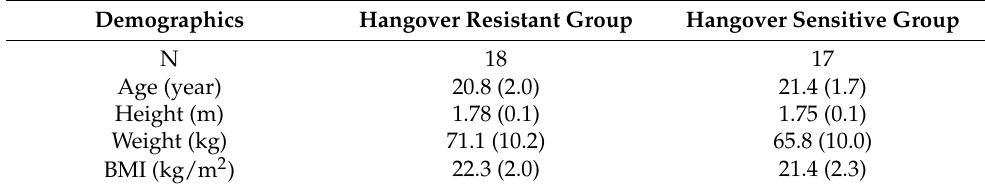
Table 1. Demographics and study